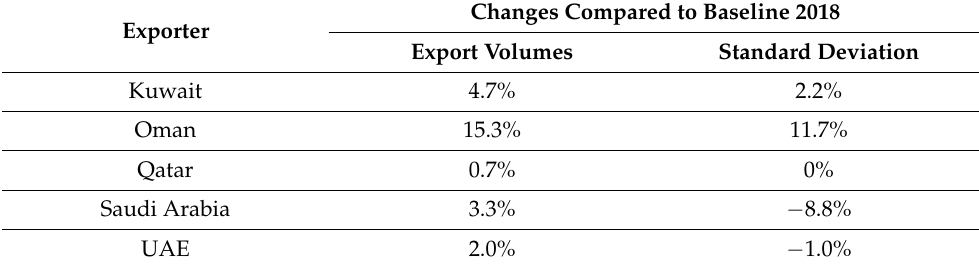
Table 6. Effects of increased oil exports to